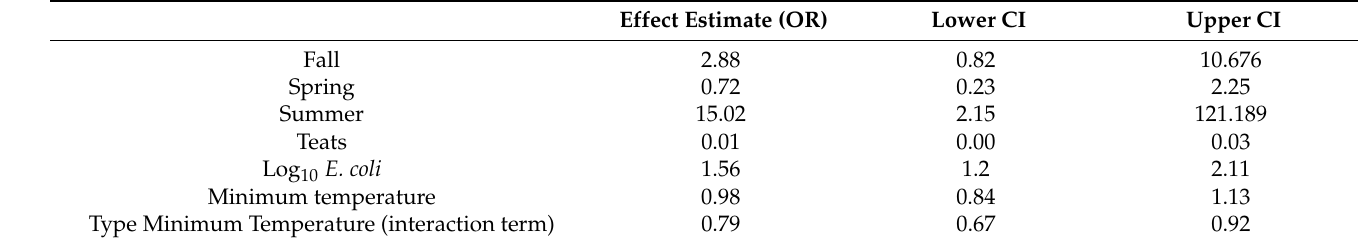
Table 3. Multi-level model with parameters with an effect on the occurrence of Campylobacter spp. in teat swab and feces samples. The confidence intervals (CI) demonstrate the variability of the odds ratio (OR). When confidence interval contains 1, the effect is not significant. Effect Estimate (OR) Lower CI Upper